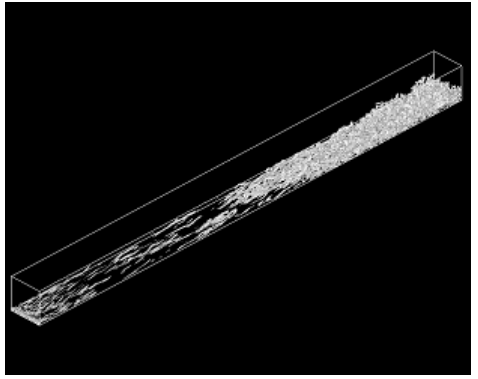
Fig. 4 Visualization of boundary layer transition by second invariant Q(=0.001)